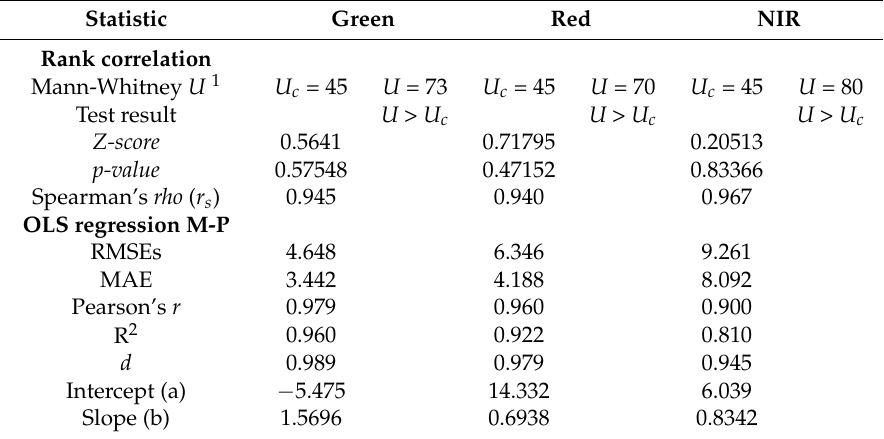
Table 18. Rank correlation and OLS regression statistics M-P from Table 17 data.